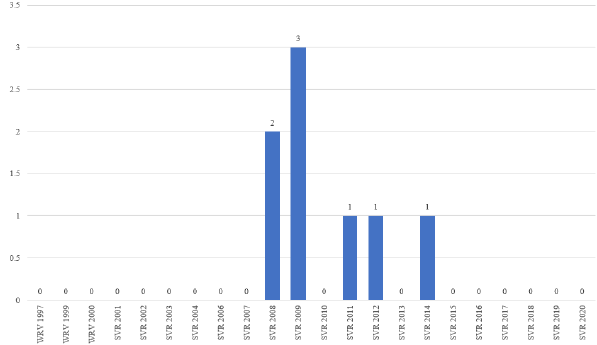
Figure 17. Overall distribution of papers from the “Teleopera- tion/telepresence” topic. From the 4 most cited works in this category, the first 3 are related to telepresence, while the last one regards teleop-